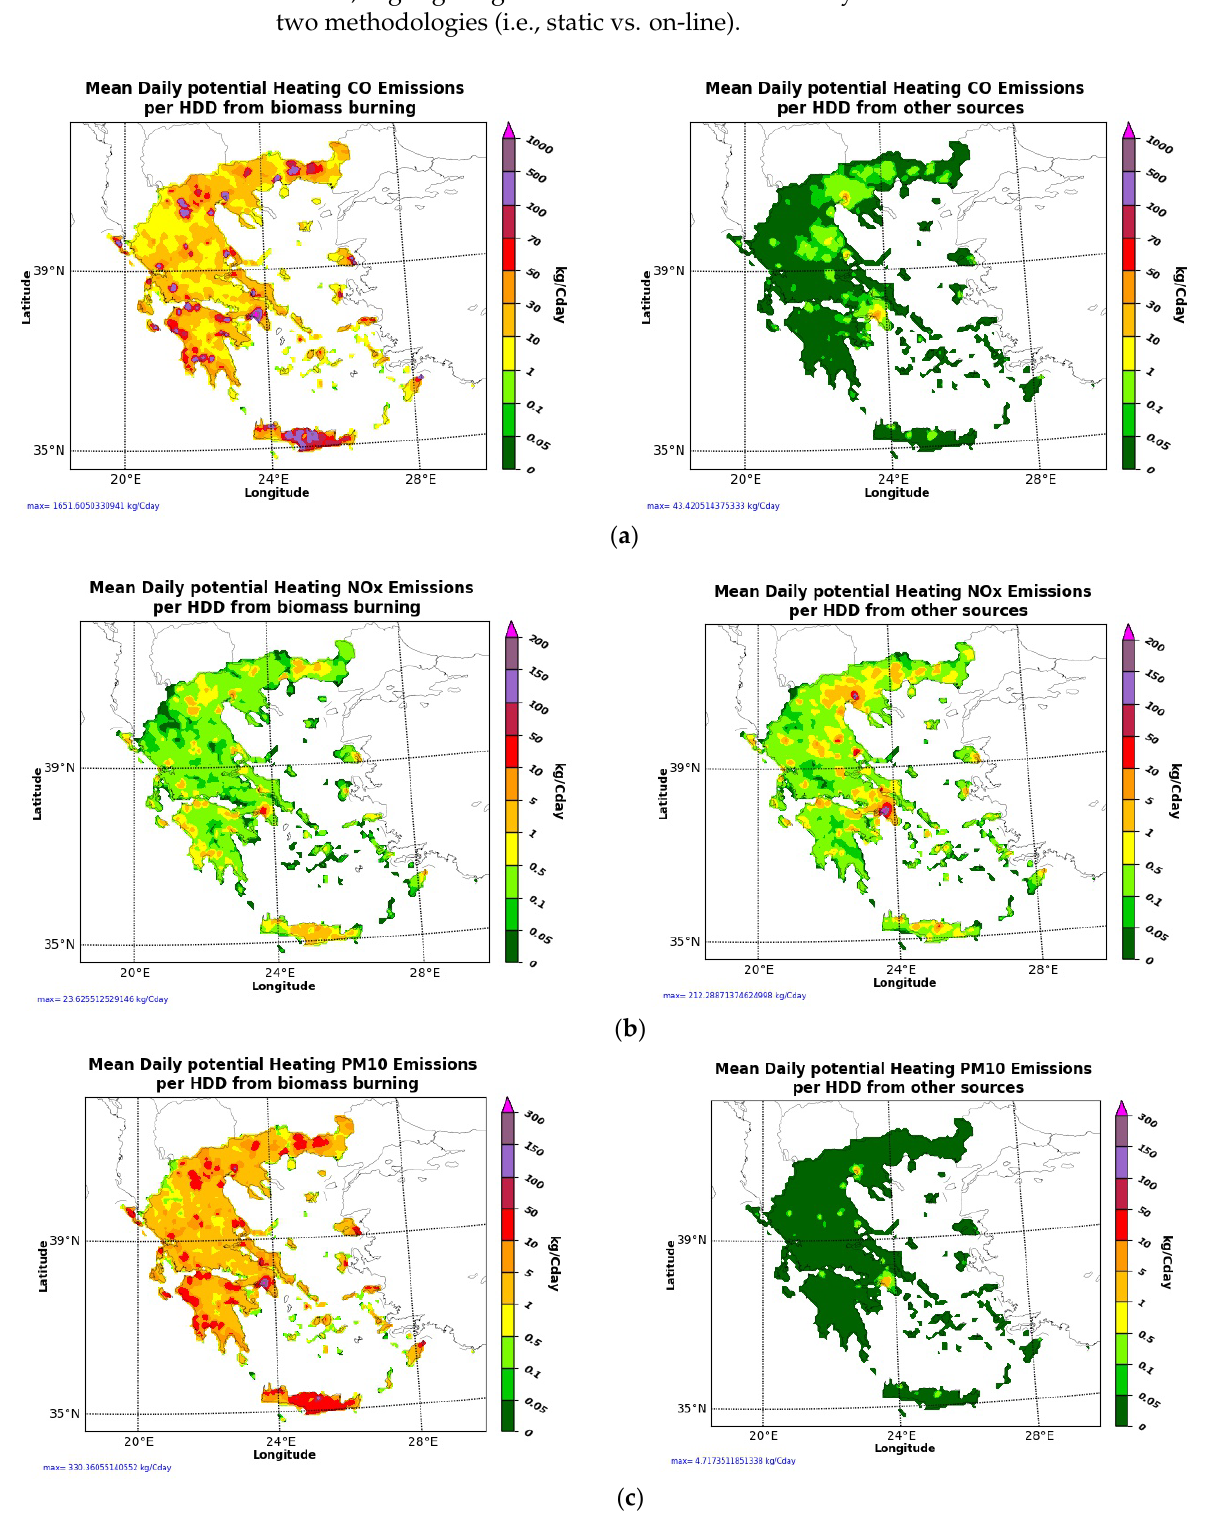
Figure 3 . Spatial distribution of mean daily potential emissions per HDD (kg/Cday) of ( a ) CO, ( b ) NO x and ( c ) PM10 from biomass burning (wood/biomass) (left) and other sources (oil, natural gas) (right) over Greece (6 × 6 km 2 , d01).